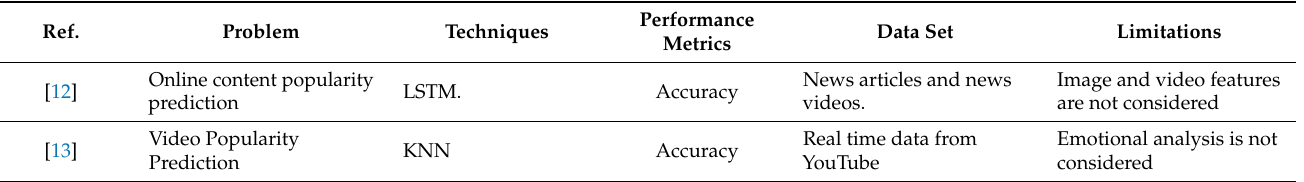
Table 2. Summary of the state-of-the-art work on video popularity prediction.